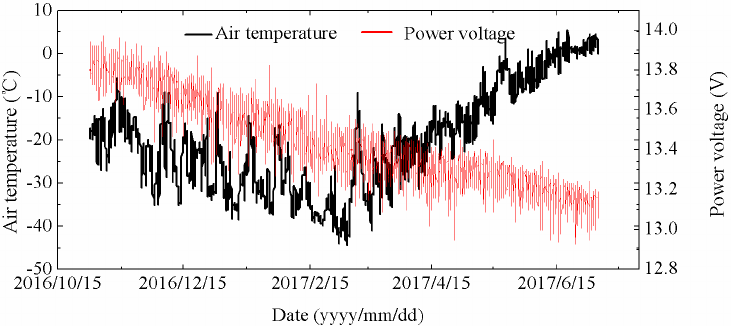
Figure 2. Air temperature and power voltage of the observing system from October 2016 to July 2017.